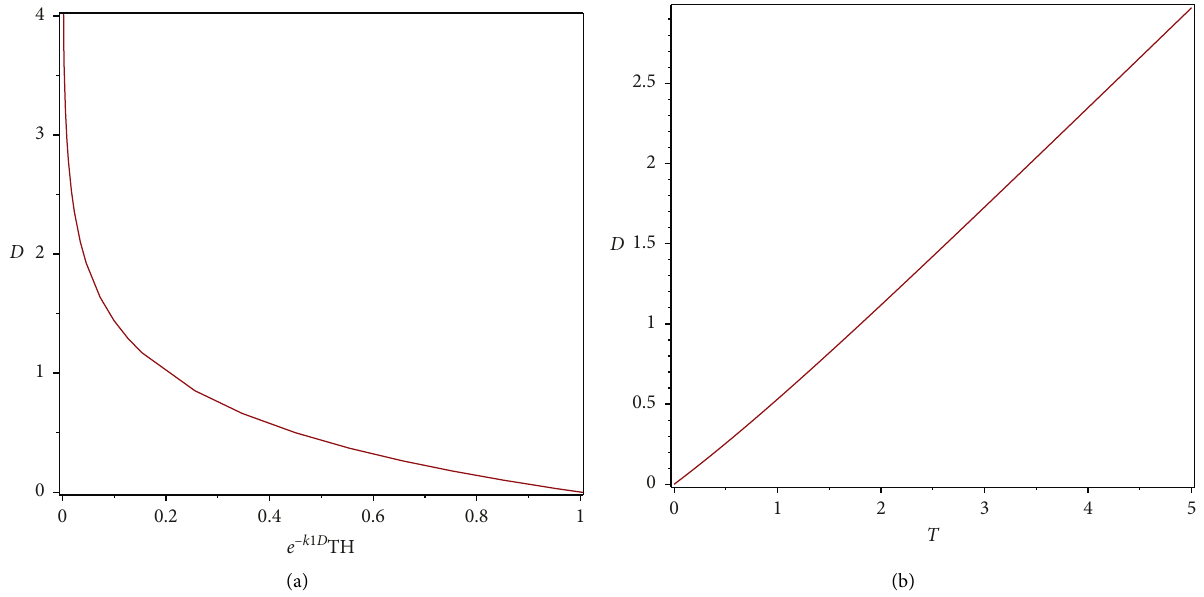
Figure 6: Effects of parameters e − k 1 D TH and T on the D of chemical control: (a) T � 20, k